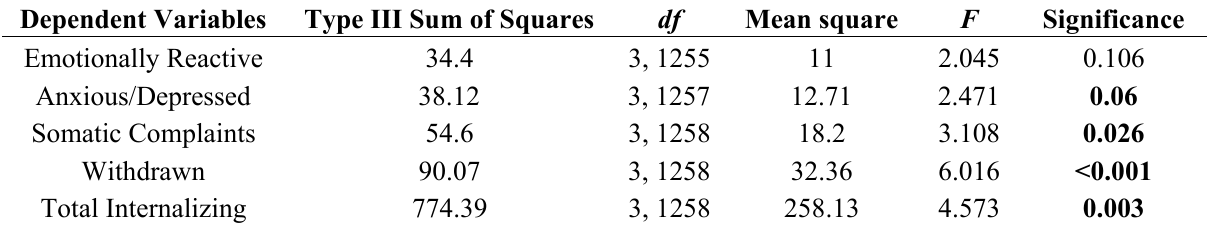
Table 3. General linear model statistics of breastfeeding type and bonding against internalizing problems, controlling for gender and social adversity.